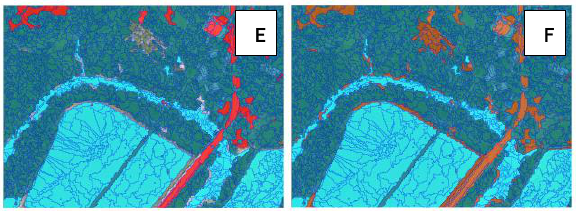
Figure 10. Classification using assign class algorithm converting all unclassified segments and Flat Surfaces class (E)